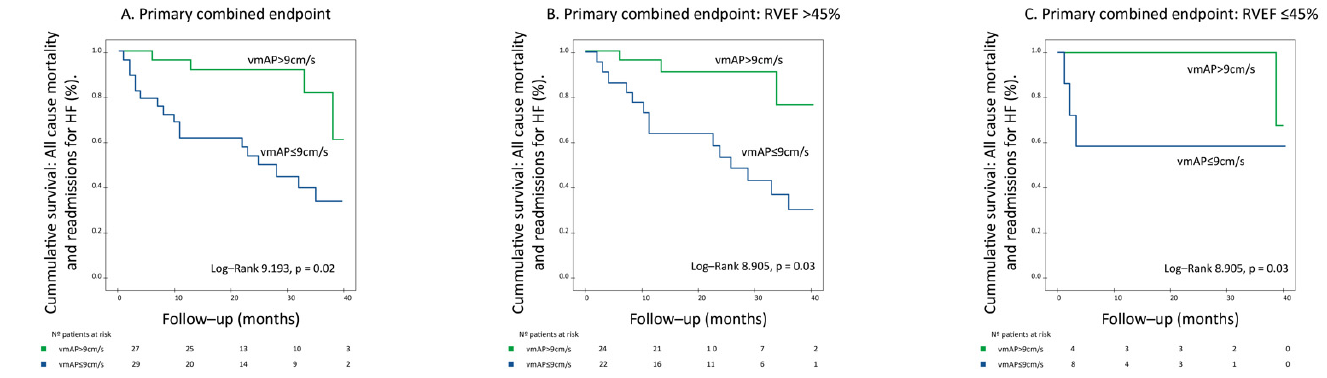
Figure 3. Survival analysis according to mvPA, as shown by Kaplan–Meier curves. ( A ) Reduced mvPA ≤ 9 cm/s was associated with higher rates of the primary combined endpoint. ( B , C ) The prognostic value of mvPA ≤ 9 cm/s for the prediction of the primary combined endpoint was maintained in patients with and without associated RV dysfunction.